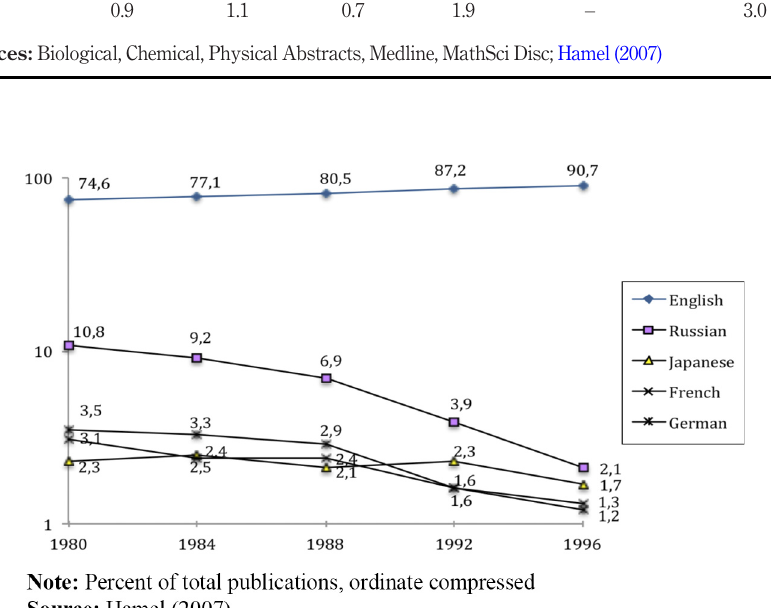
Table I. Share of languages in several natural sciences in 1996